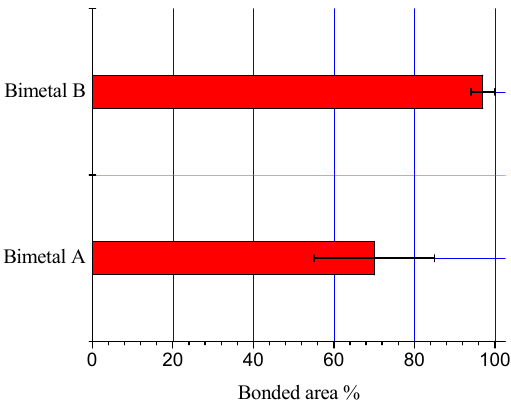
Figure 5. Bonded area in the samples S0 and S1.